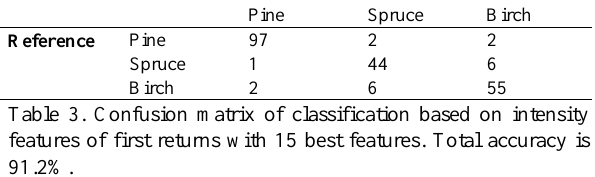
Table 5. Confusion matrix of classification based on intensity features and point cloud features of first returns. Total accuracy: